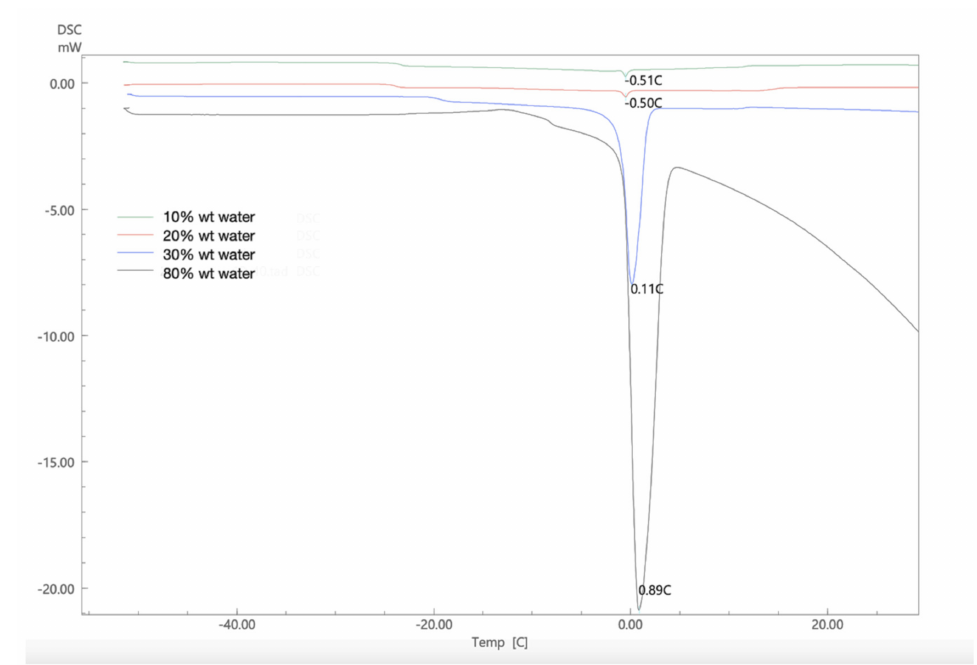
Figure 4. DSC thermogram of lidocaine nanoemulsion with increasing water content using beeswax at surfactant − to − oil ratio